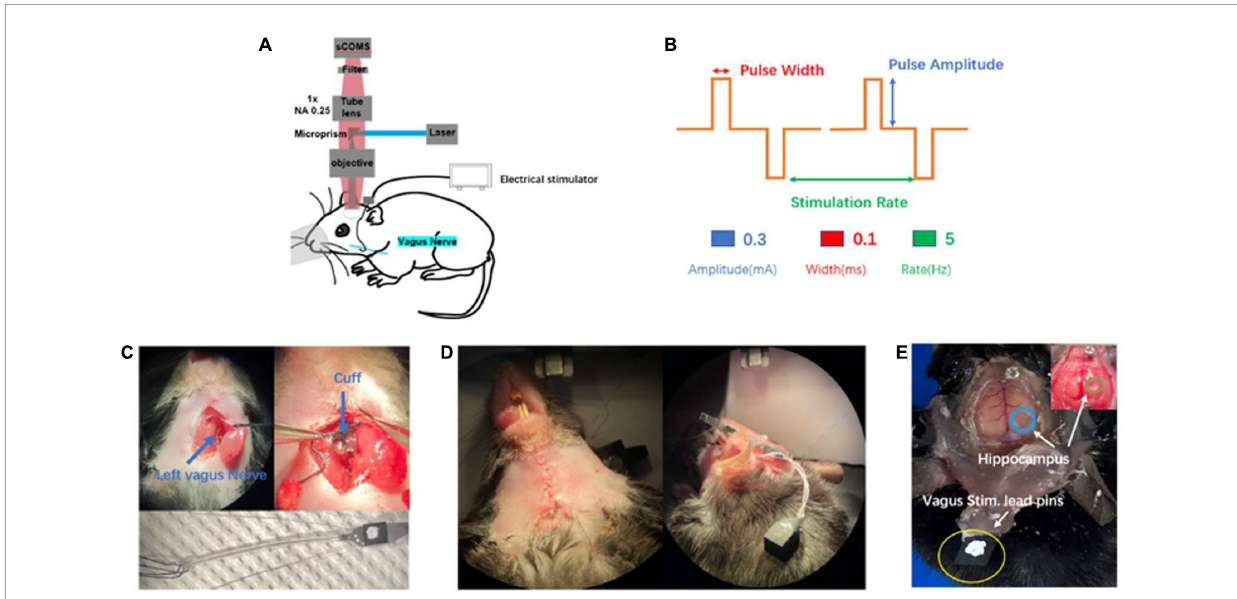
FIGURE1 Introduction of in vivo wild-field imaging and vagus nerve stimulation (VNS). (A) Schematic diagram of in vivo imaging and vagus nerve stimulation, illustrating that the mouse is under overhead objective for in vivo calcium brain imaging and the cuff electrode is positioned around vagus nerve(blue). (B) Schematic of VNS pulse waveforms and parameters. Biphasic pulse was delivered in trains lasting 10 s (top). VNS was delivered by the parameter combination of 0.3 mA, 0.1 ms, and 5 Hz (bottom). (C) Photograph of vagus nerve cuff position (top) and bipolar VNS cuff design (bottom). (D) Photograph of subcutaneous tunnel made in between the ear and eyes from neck incision to the top of the head. (E) Photograph of the awake mouse with the fixed head post, showing simultaneous exposure of cerebral cortex and hippocampus (blue and green) as well as vagus stimulation lead pins (yellow) fixed to the rear of the head post using acrylic dental